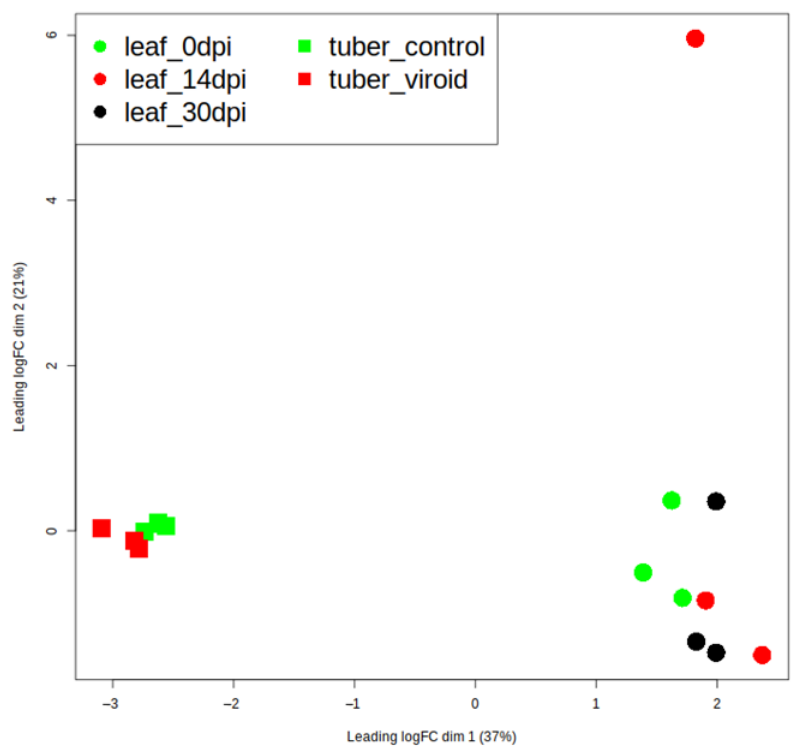
Figure 3. Clustering of mRNA-seq libraries with multidimensional scaling.